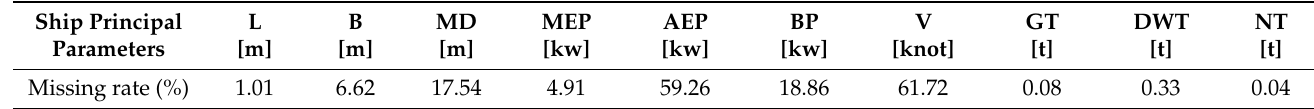
Figure 9. Bar chart comparing the four imputation models under real missing rates. Table 9. Real missing rates for 10 design parameters.